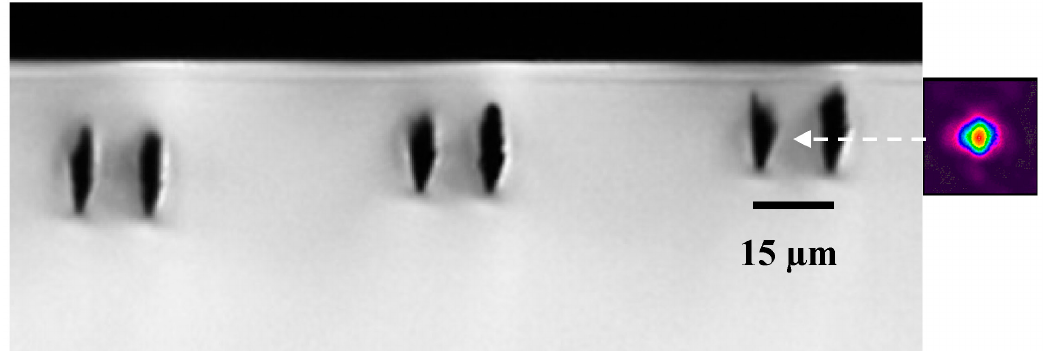
Figure 3. Side view optical microscope image of type II modification in diamond, with modification tracks separated by 15 µm. The laser processing conditions were 500 kHz repetition rate, 60 nJ pulse energy, and 0.5 mm/s scan speed. The waveguide depths (left to right) were and 20, 15, and 12 µm. Coupling to a single vertical position was possible with depths below 30 µm, with the minimum depth being 12 µm for waveguide operation. Mode profile at 635 nm characterization wavelength shown for the shallowest waveguide. Note that the color linear scale varying from 0 (violet) to 1 (red) indicates the relative intensity of the mode profile, normalized to the peak intensity. The 15 µm scale bar is the same for the mode and microscope image.